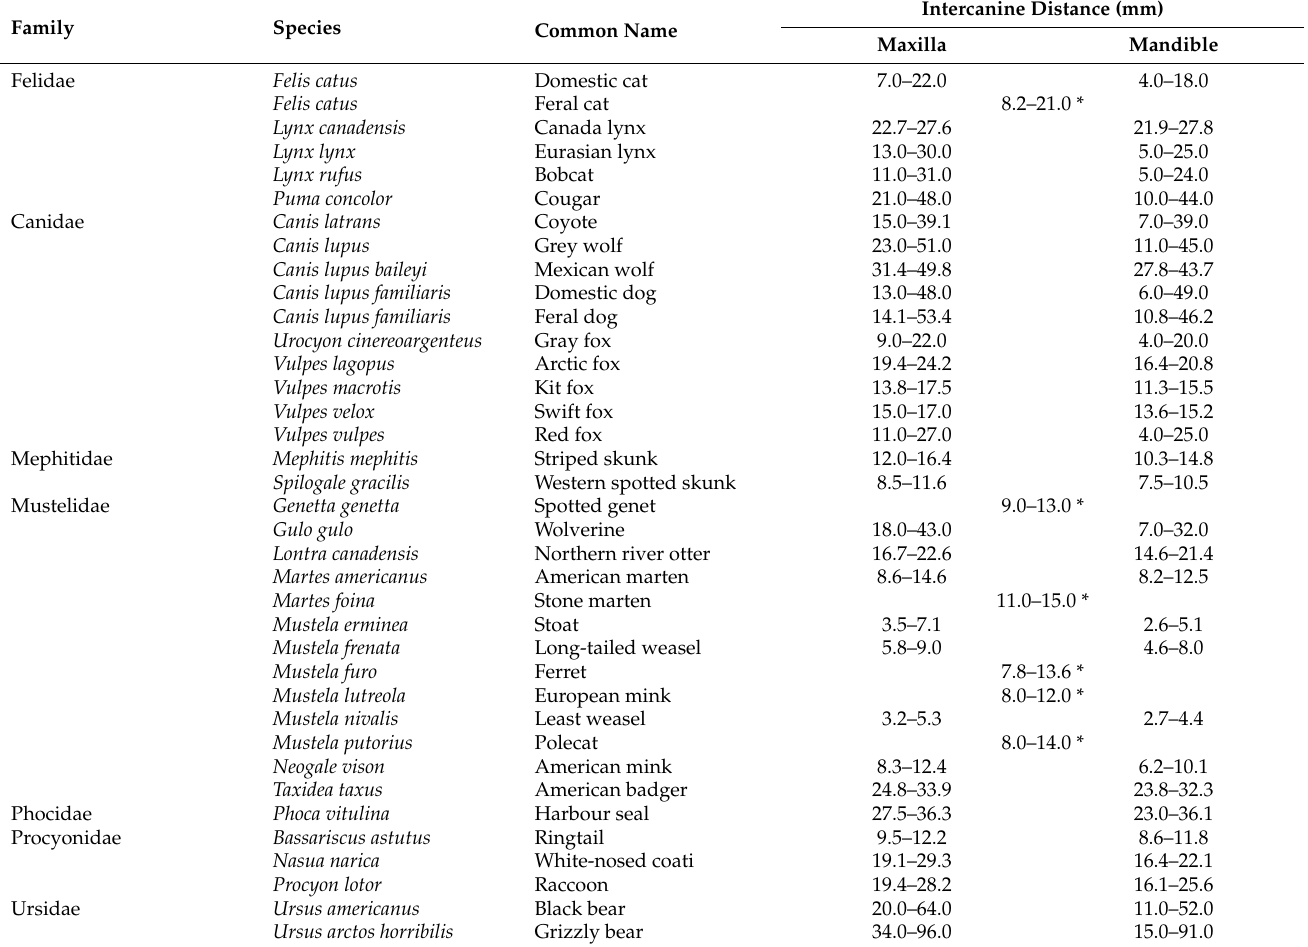
Table 2. Ranges of intercanine distances in some species of the order Carnivora (data from